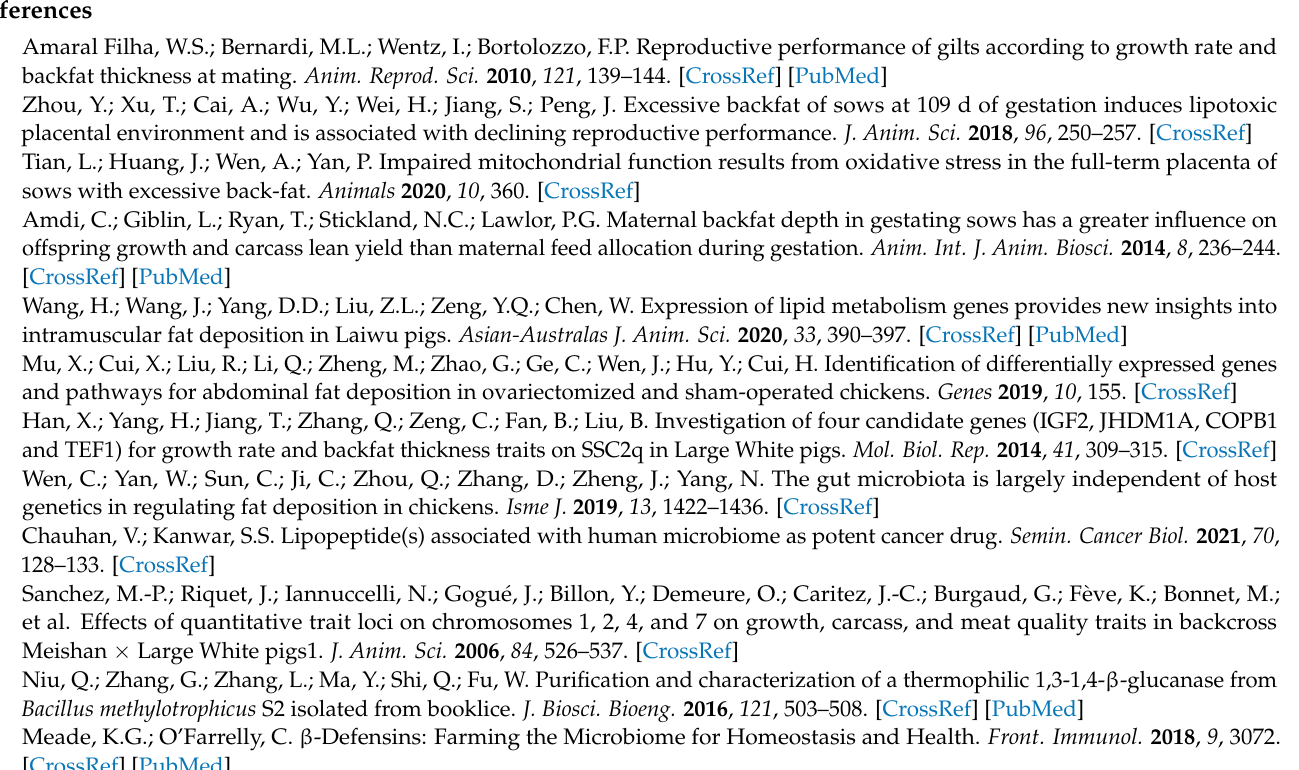
Table S3: KEGG orthology analysis; Table S4: KEGG pathway